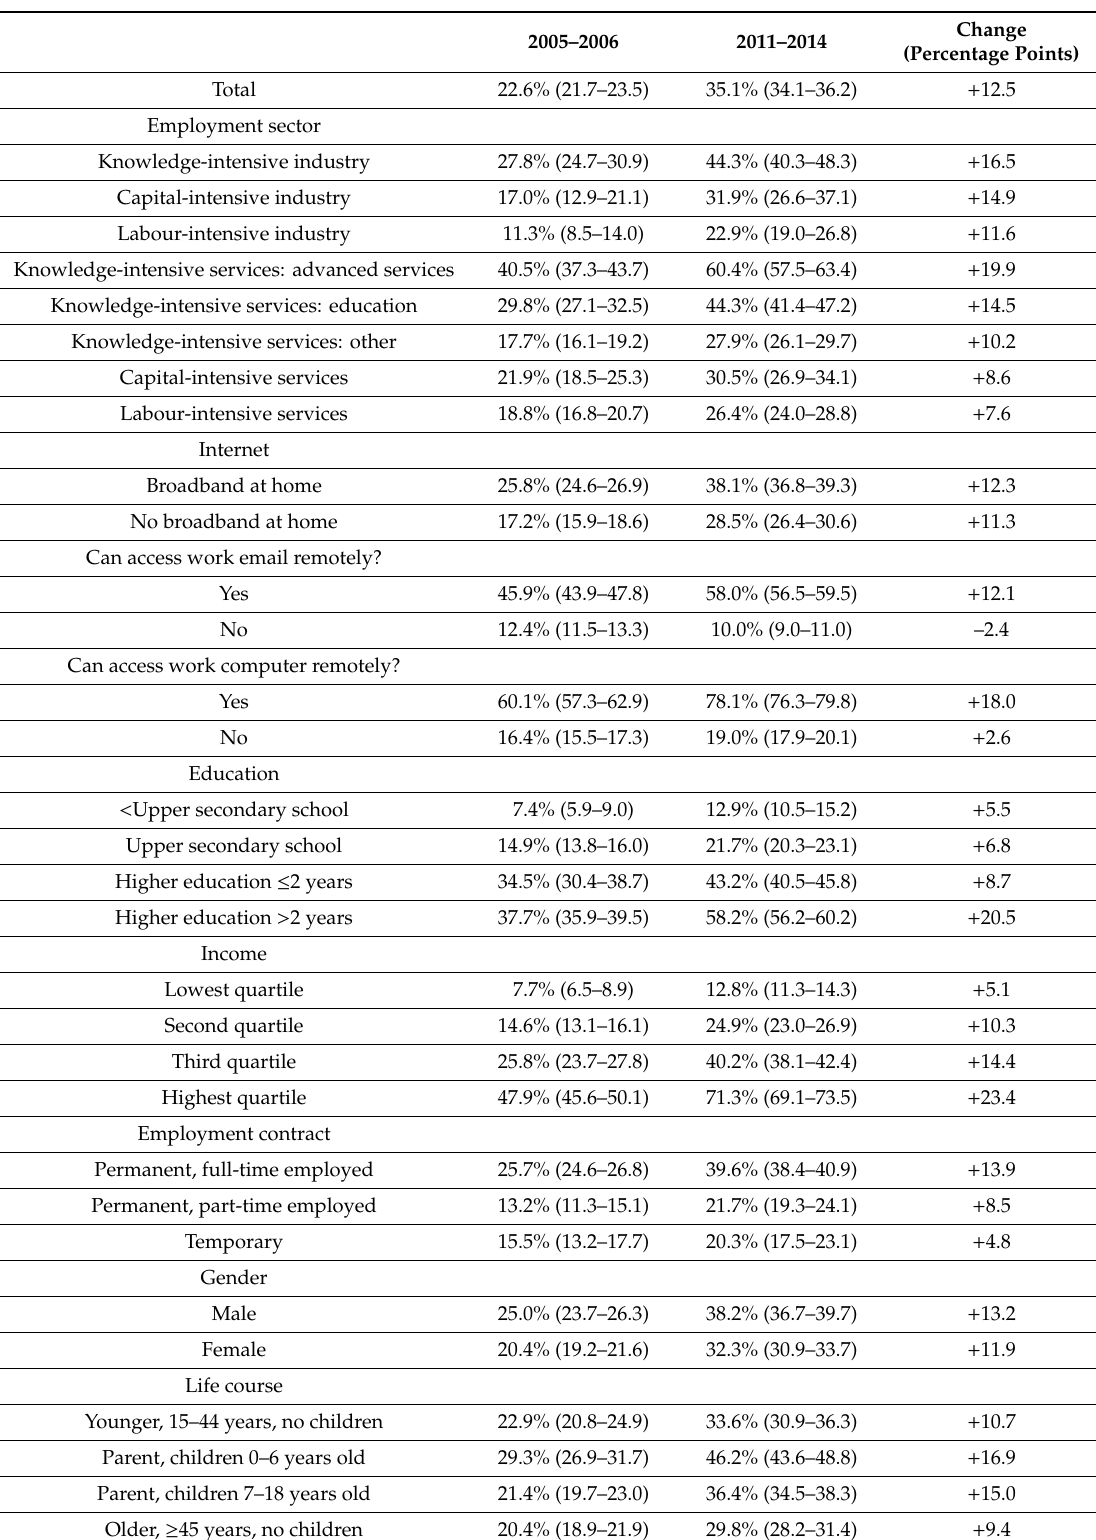
Table 2. Telework eligibility: personal and employment characteristics, within-group shares (95% confidence intervals in parentheses) and relative